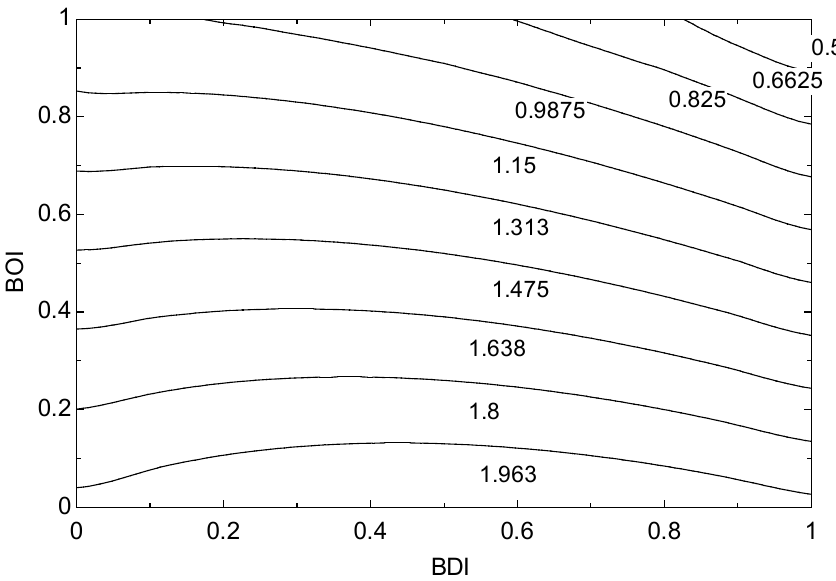
Figure 5. Normalized building energy usage